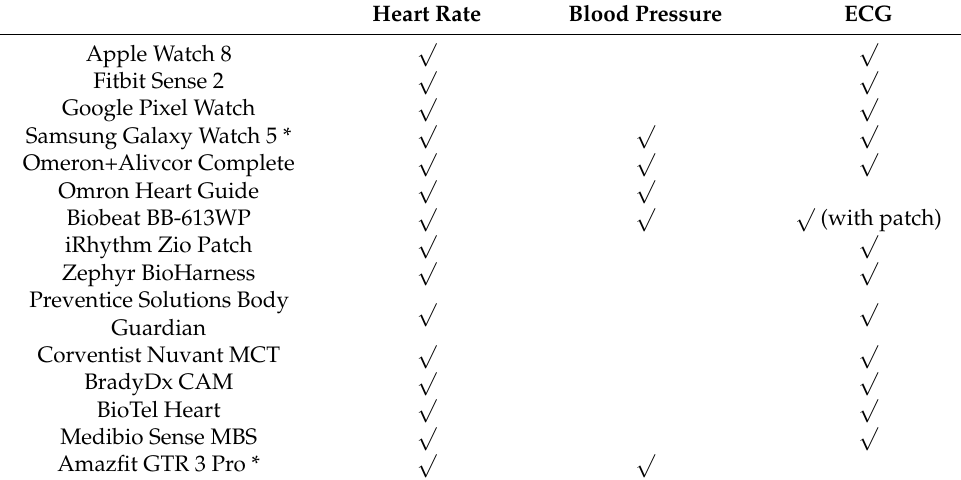
Table 1. Summary of FDA-approved popular wearable devices on the market. Heart